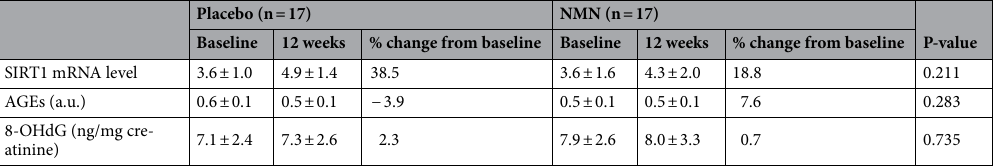
Table 5. Health parameters of the placebo and the NMN intake groups before and after the intervention period. Values are presented as mean ± standard deviation. Primary efficacy variables were statistically analyzed using a full-analysis-set population. Analysis of covariance (ANCOVA) was applied for significance between the two groups using the baseline as a covariate. Statistical significance was set at p < 0.05. SIRT1 sirtuin 1, AGEs advanced glycation end products, 8- OHdG 8-hydroxydeoxyguanosine, NMN nicotinamide